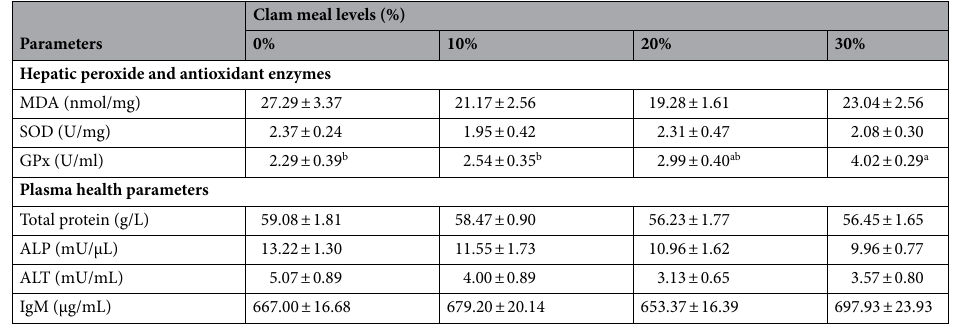
Table 7. Hepatic and plasma health parameters. MDA Malondialdehyde, SOD superoxide dismutase, GPx glutathione peroxidase, ALP Alkaline phosphatase, ALT alanine aminotransferase, IgM immunoglobulin M. a,b Mean values within a row with unlike superscript letters were significantly different ( P < 0.05).